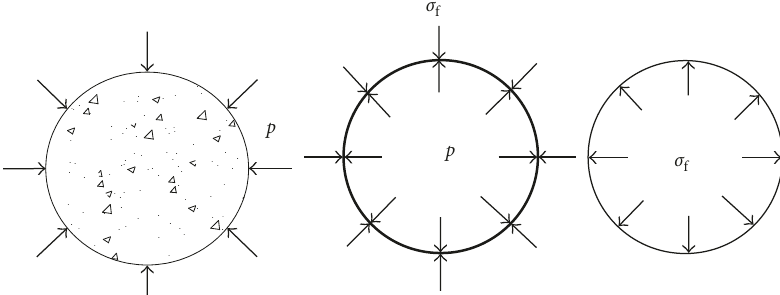
Figure 2: Stress model in the composite column under compression. (a) Concrete. (b) Steel tube. (c) CFRP